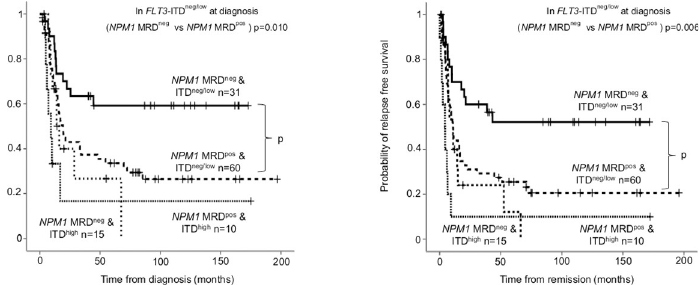
Fig 4. Overall survival and relapse free survival according to NPM1 MRD stratified by FLT3 -ITD allelic ratio. Based on the ELN 2017 genetic risk stratification, NPM1 positive patients were categorized in to favorable ( FLT3 - ITD neg/low ) and intermediate ( FLT3 -ITD high ) subgroups. On both panels (A: overall survival; B: relapse free survival), further subgroups were established according to NPM1 MRD after induction. NPM1 MRD negativity was defined as VAF < 0.01–0.05% depending on mutation